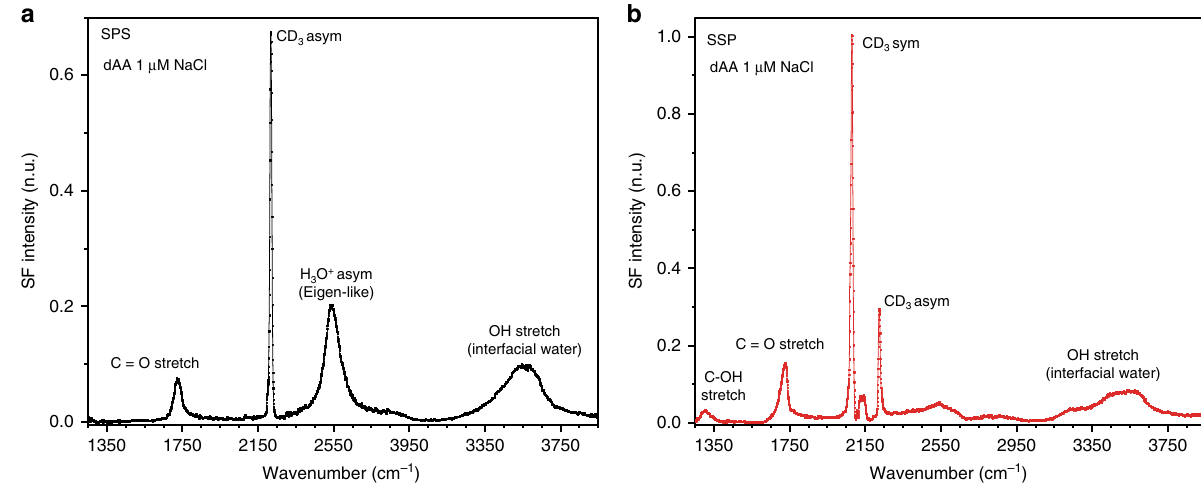
Fig. 1 Interfacial spectral features of the carboxylic acid monolayer. VSF spectra of a perdeuterated arachidic acid (dAA) Langmuir monolayer on a 1 μ M NaCl solution at pH~6 collected under the ( a ) SPS, and ( b ) SSP polarization combinations. The different polarizations provide complementary information about the surface species and their orientation. The assignements are taken from refs. 26 – 29 and this study (see text). Measurements are carried at 22 °C and a constant surface pressure of 20 mN m − 1 , corresponding to an area per molecule of ~20 Å 2